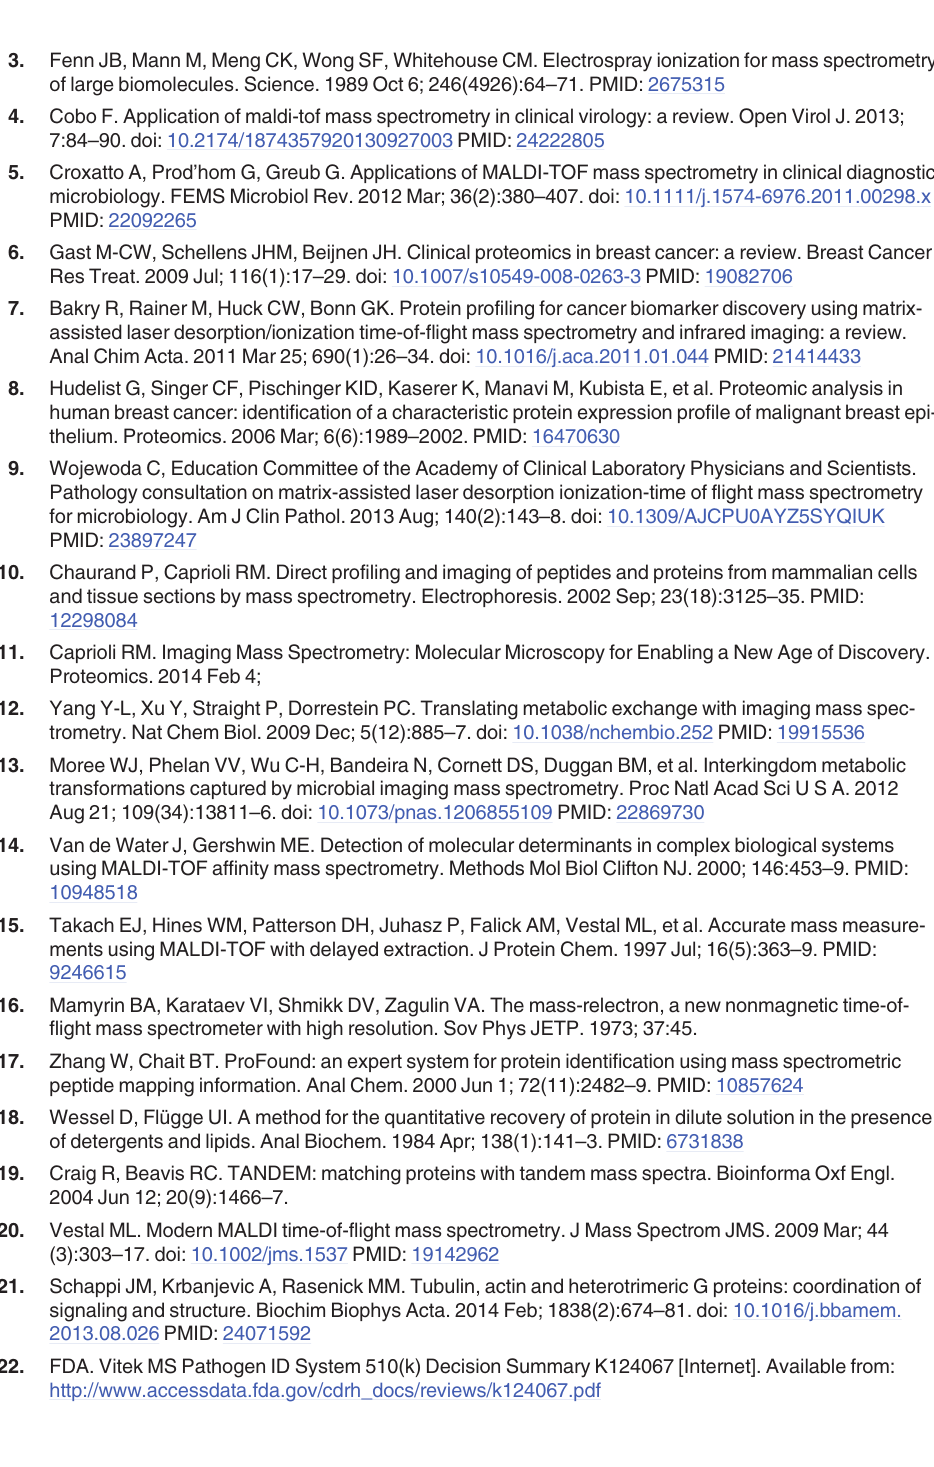
PLOS ONE | DOI:10.1371/journal.pone.0120932 March 23,